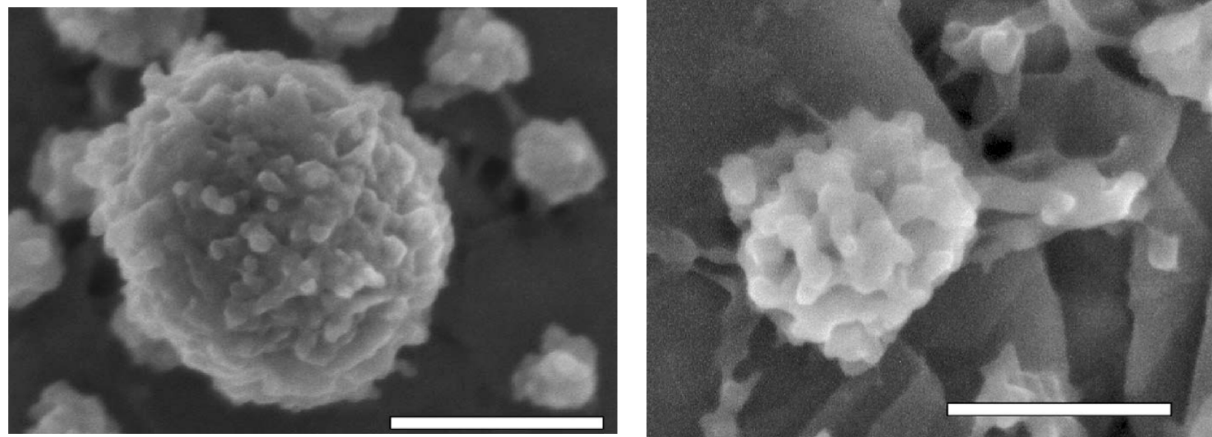
Figure 4. SEM micrographs of intact ( left ) and dissociated ( right ) casein micelles. Scale: 200 and 100 nm, respectively [49]. Reproduced with permission from Douglas G. Dalgleish, Paul A. Spagnuolo, H. Douglas Goff, A possible structure of the casein micelle based on high-resolution field-emission scanning electronmicroscopy; published by Elsevier, 2004.